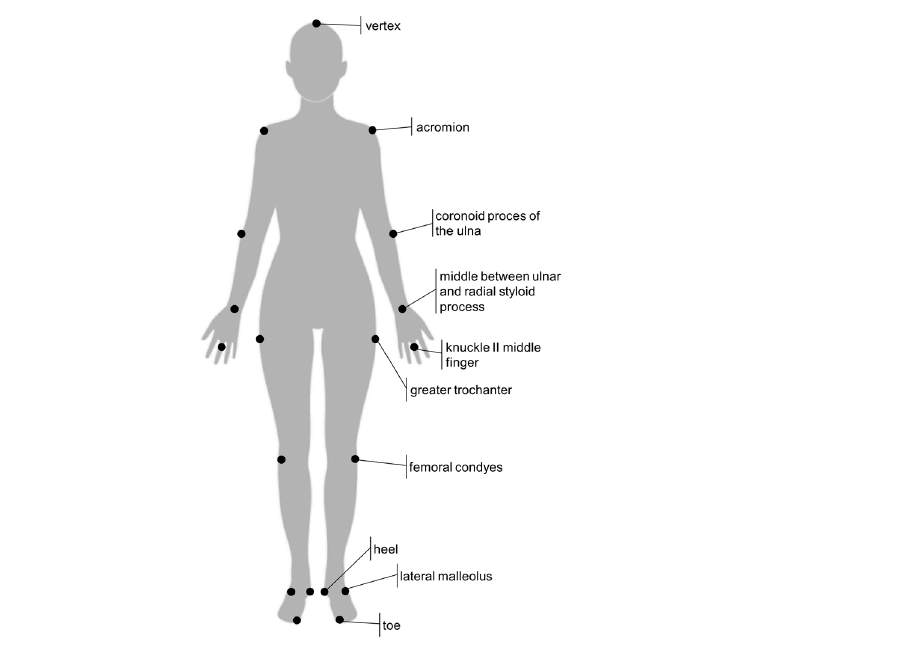
Figure 2. Placement of passive markers on the subject’s body.